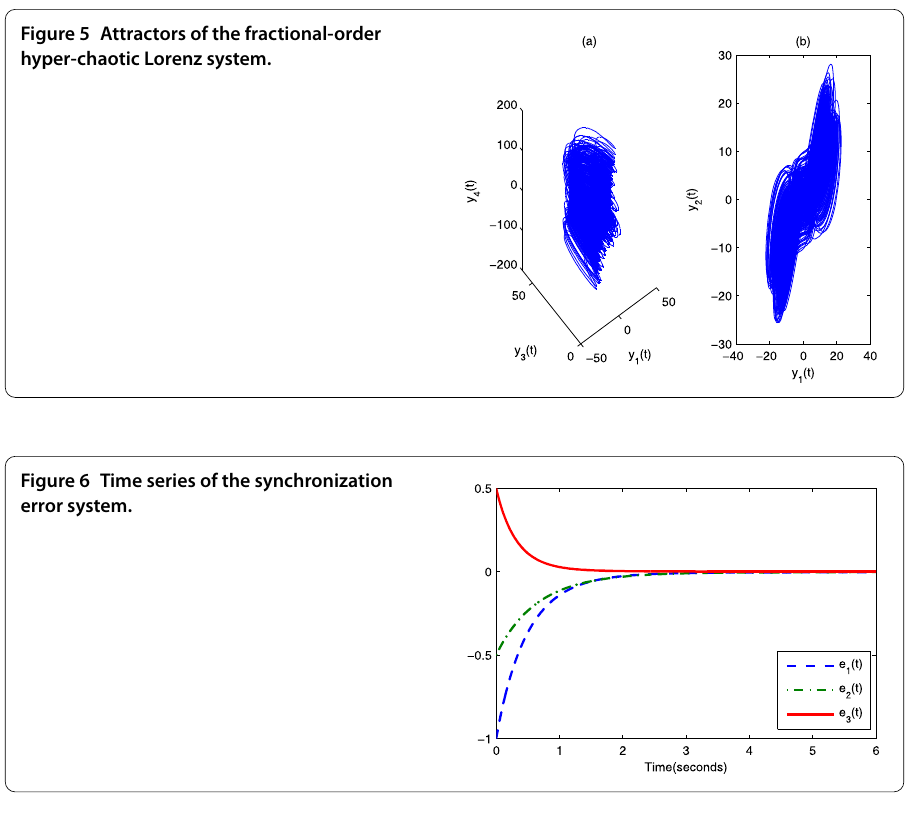
Figure 5 Attractors of the fractional-order hyper-chaotic Lorenz system.